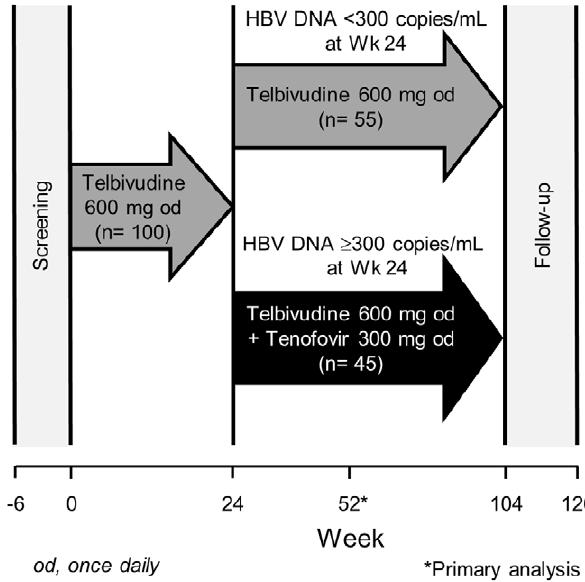
Figure 2. Study design.